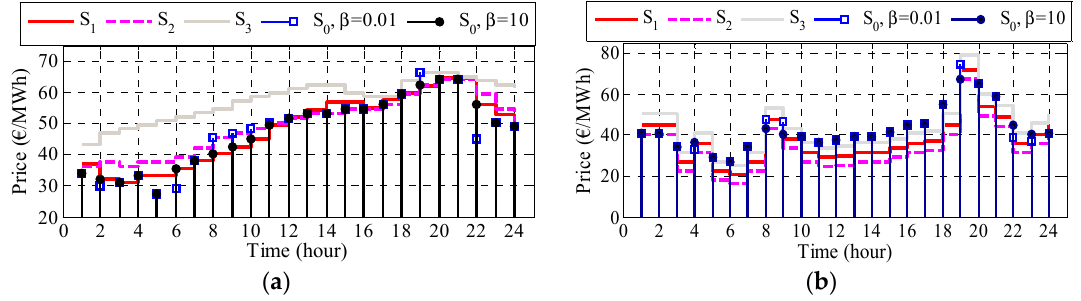
Figure 6. The price signal offered by aggregators ( a ) in charge process; ( b ) in discharge process.